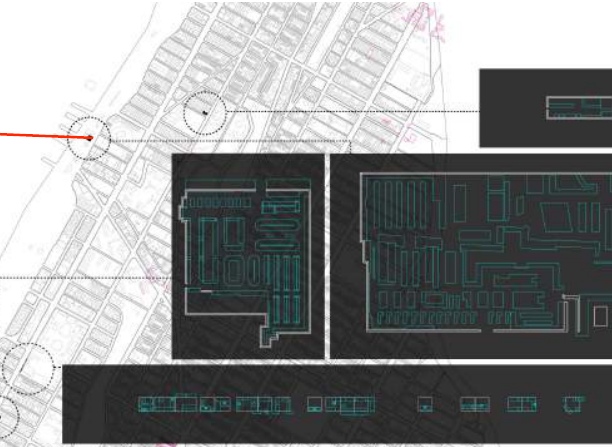
Figure 4. Food retail by size, type and location, Morningside Heights, NYC. Clockwise from top: Bodega, 900 ft 2 ; Supermarket on marginal land, 16,000 ft 2 retail/ 6,000 ft 2 storage; Biweekly farmers’ market 400 ft long; Standard supermarket, 9,800 ft 2 /3,000 ft 2